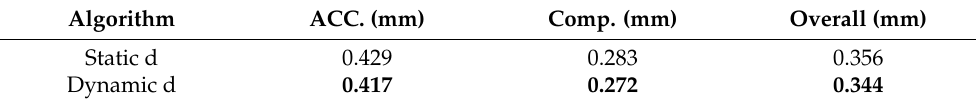
Table 4. Effect of dynamic interval on experimental results.